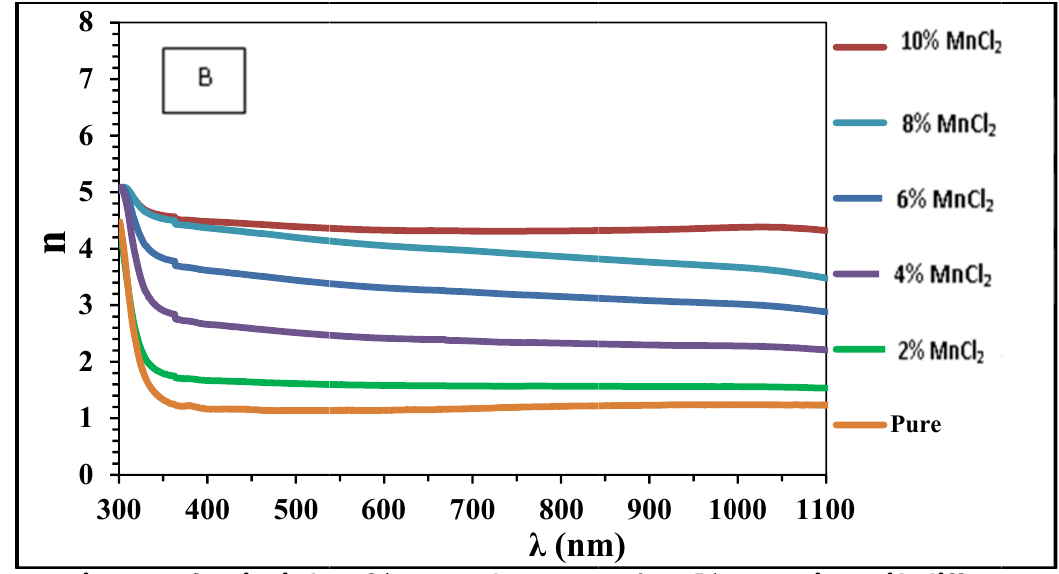
and PVA:PE ntration of